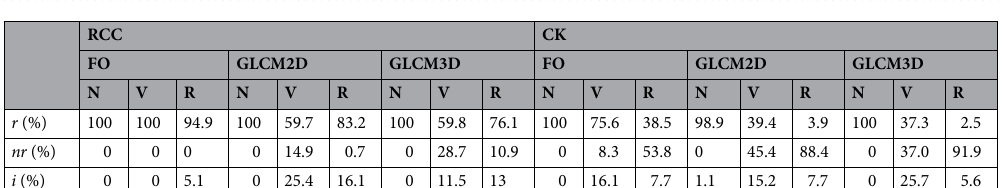
Figure 3. Overall percentage of robust ( r ), non-robust ( nr ), and with indeterminate robustness ( i ) features against image perturbation for RCC ( a ) and CK ( b ), separately. Feature robustness is also reported per each feature class (i.e. FO, GLCM2D, and GLCM3D) for RCC ( c ) and CK ( d ).